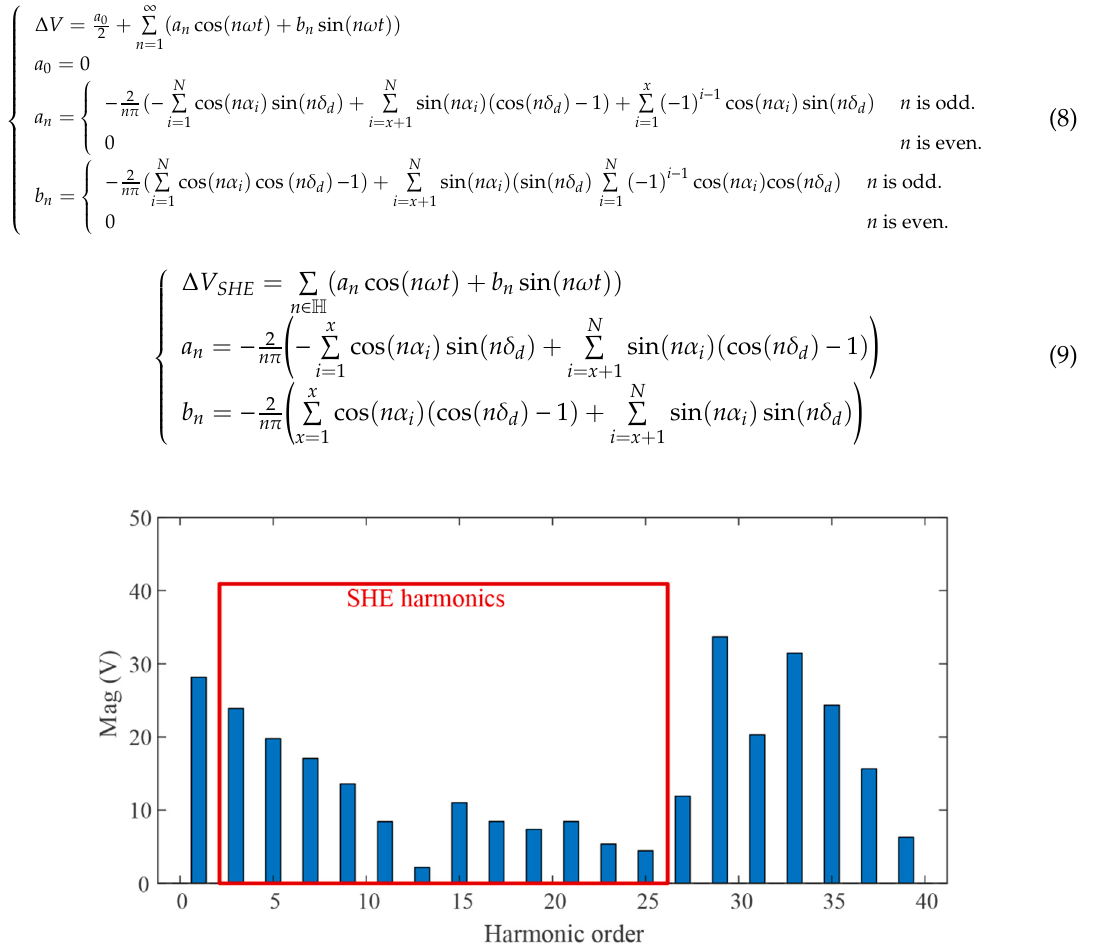
Figure 9. Harmonic distribution of ∆ V , with θ = 30 ◦ , T d = 10 µ s, M = 0.95, and N = 9 .